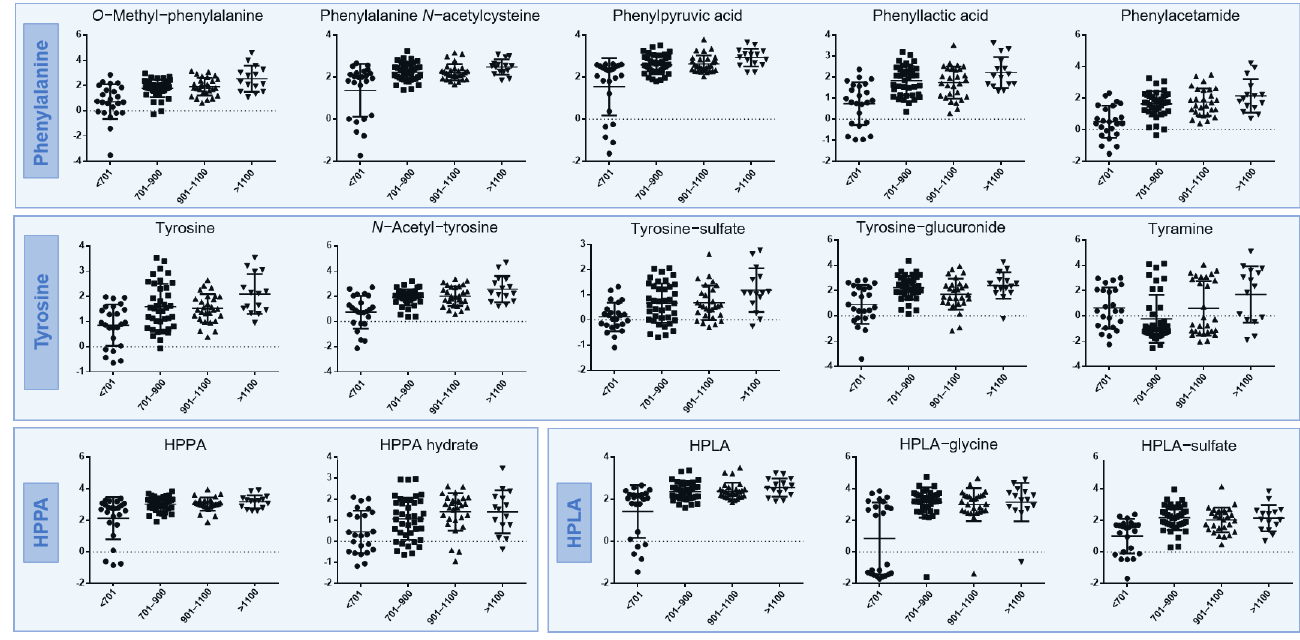
Figure 3. Comparison of urine metabolite abundance between corresponding sTYR concentration (µmol/L) threshold groups for samples from nitisinone-treated patients only; visits 4 and 6 combined. Data shown are from metabolites that showed statistically significant differences between sTYR groups. All data are scaled, transformed and normalised peak areas, as described. Central bars and outer bars represent mean and SD, respectively.